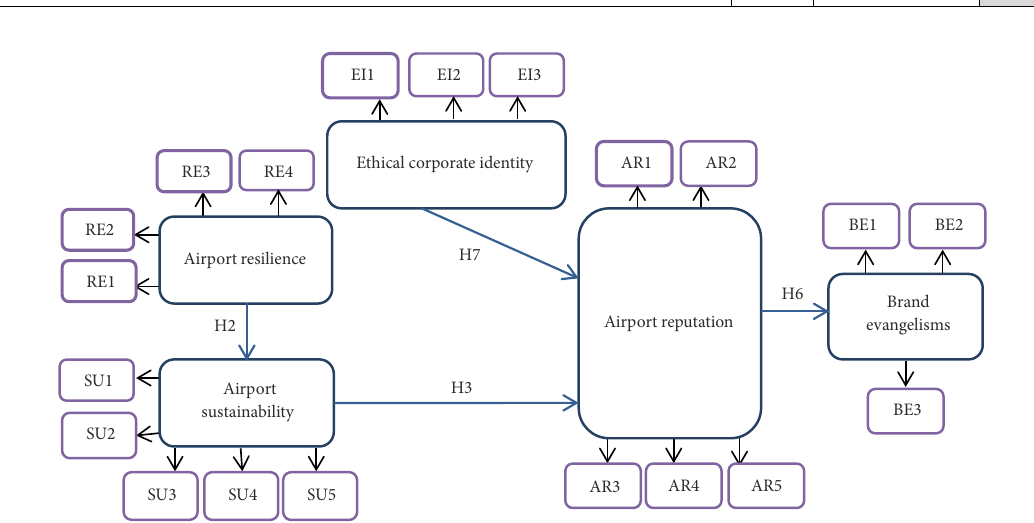
Figure 2. Final conceptual model of this